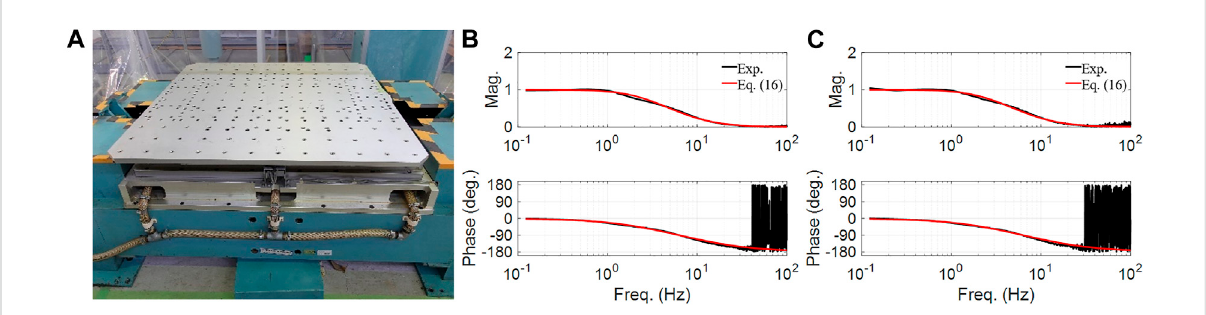
FIGURE 9 Shake tablewith barecondition: (A) photo and (B) tabledynamics identi fi edbytherandomexcitation(15 mm)and (C) table dynamics identi fi ed by the random excitation (5